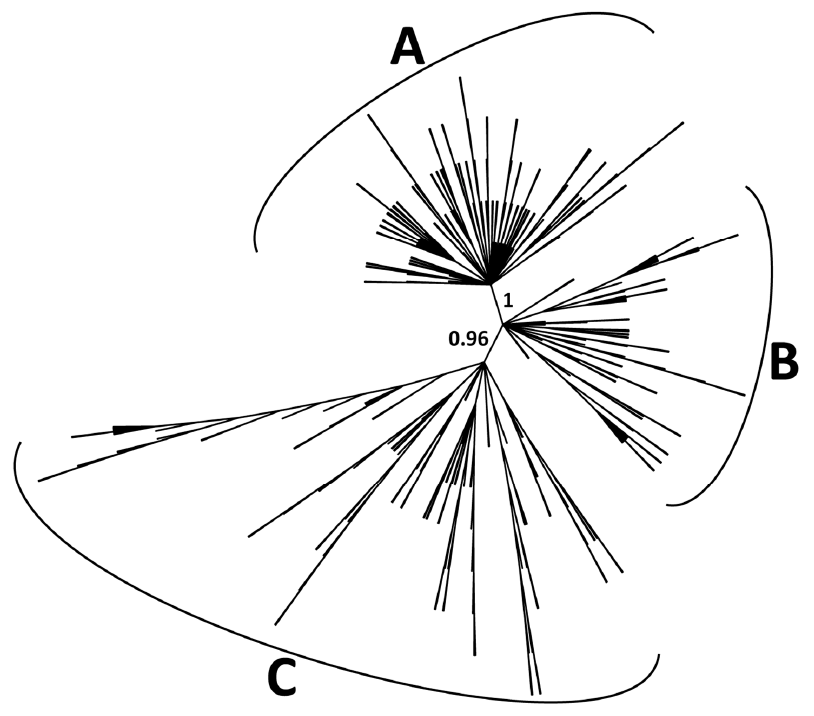
Figure 2. Phylogenetic tree of CACTA elements based on the TR sequences (347 sequences clustered). Bootstrap values higher than 0.9 are shown for basal nodes.